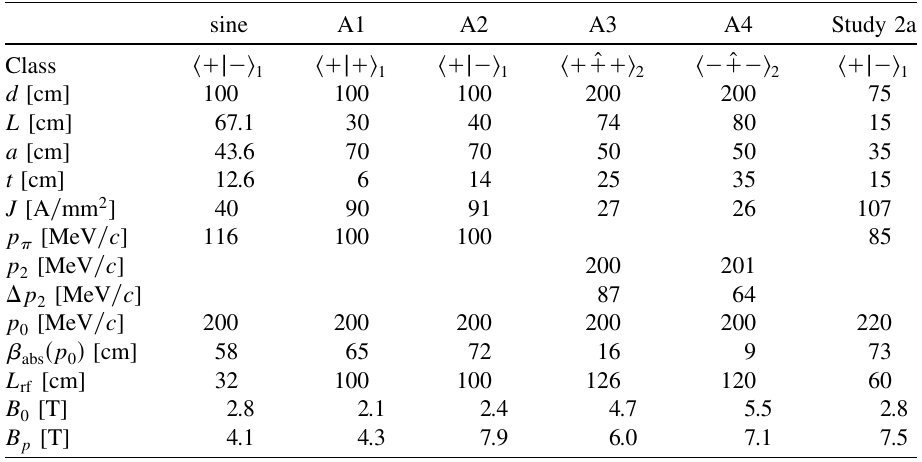
TABLE III. Summary of the one-cell lattice solutions sine